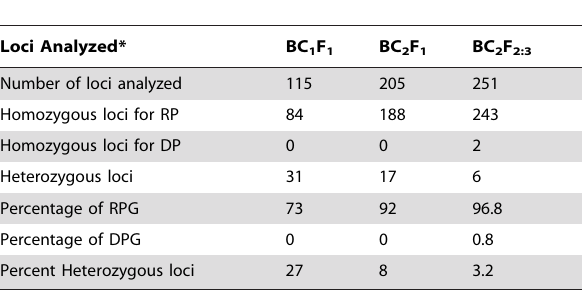
Table 2. Recurrent parent genome (RPG) recovery by